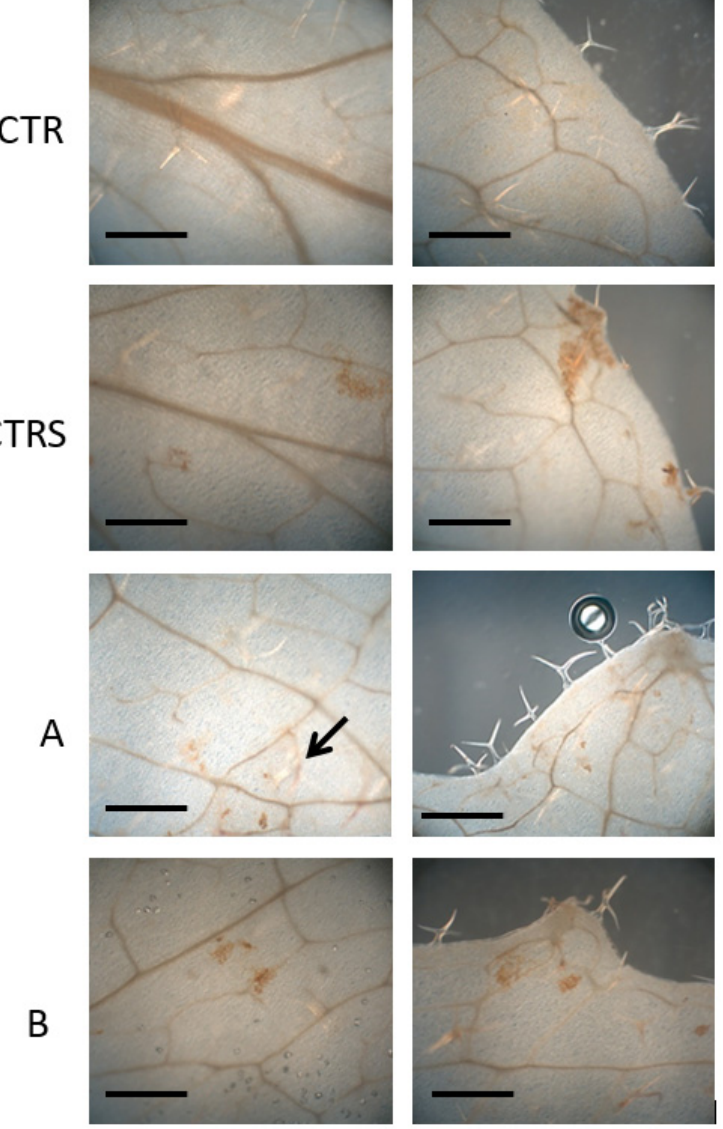
Figure 3. ROS histolocalization by DAB staining on mature leaves. The brown spots represent the sites where ROS are accumulated. For each sample, one picture was taken from the central area of the leaf blade (left) and one from the leaf border (right). CTR: non-stressed control, CTRS: stressed control, A: Phylgreen, B: Delfan Plus. Bars: 500 µm. The arrow indicates the faint signal caused by treatment drops.